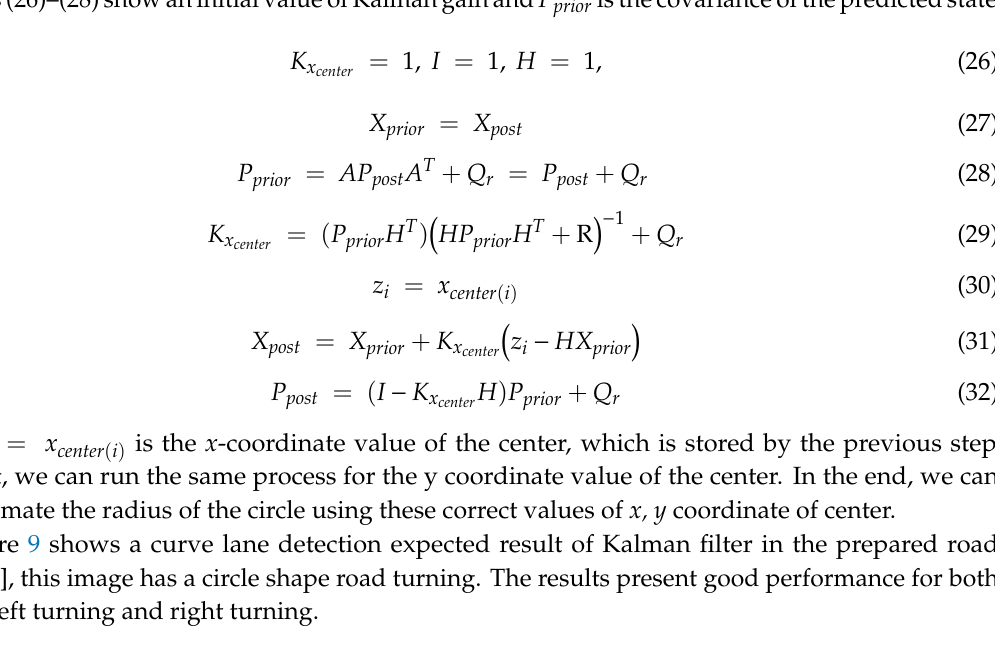
Figure 10. Centrifugal force when a car goes around a curve. 3. Setup for Simulation in 3D Environments and Results The 3D lane detection environment for simulation is designed using the GAZEBO simulator. MATLAB is used for image preprocessing, lane detection algorithm, and closed-loop lane keeping control, shown in Figure 11a. It shows the software communication in brief. ( a )